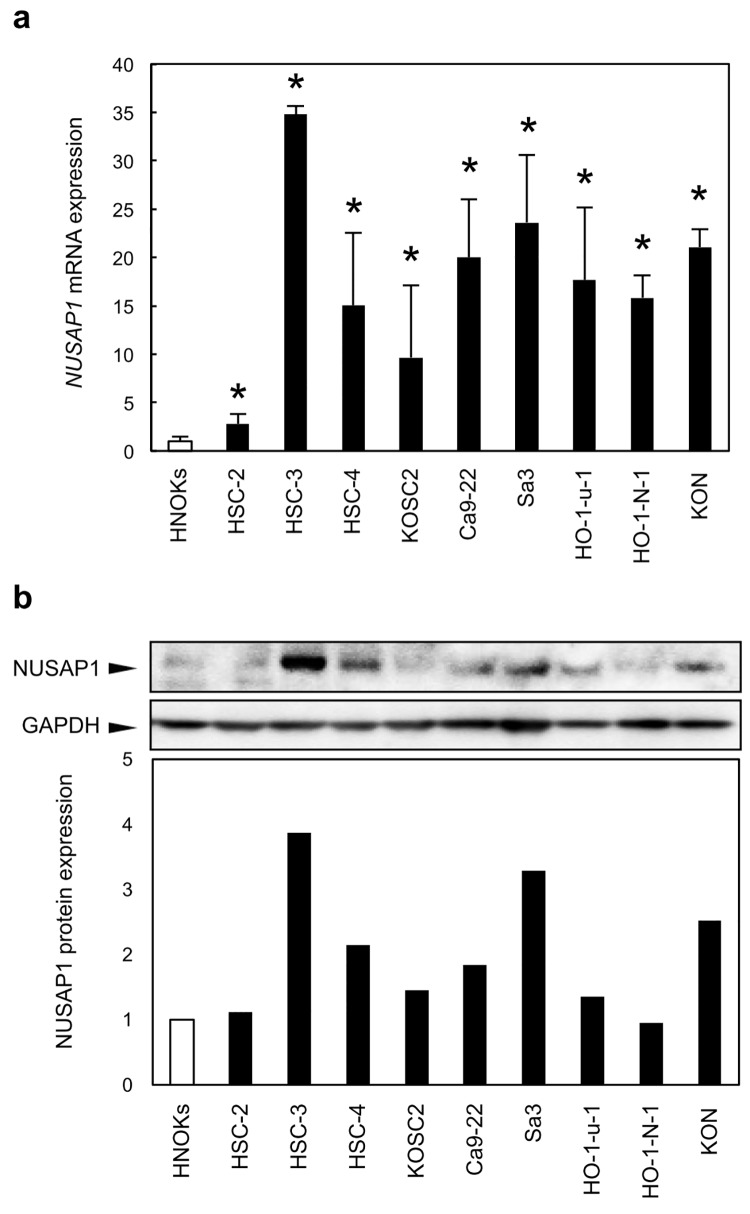
Evaluation of NUSAP1 expression in OSCC-derived cell lines.a. Quantification of NUSAP1 mRNA expression levels in OSCC-derived cell lines by qRT-PCR analysis. mRNA expression levels are normalized to GAPDH. Significant (p < 0.05, Mann-Whitney’s U test*) up-regulation of NUSAP1 mRNA is seen in nine OSCC-derived cell lines (HSC-2, HSC-3, HSC-4, KOSC2, Ca9-22, Sa3, HO-1-N-1, HO-1-u-1, and KON) compared with the HNOKs. Data are expressed as the means ± SEM of triplicate results. b. Representative immunoblotting data of NUSAP1 in OSCC-derived cell lines and HNOKs show that NUSAP1 protein expression is up-regulated in OSCC-derived cell lines compared with the HNOKs. The molecular weight of the NUSAP1 is 49 kDa. Densitometric NUSAP1 protein data are normalized to GAPDH protein levels. The values are expressed as a percentage of the HNOKs.